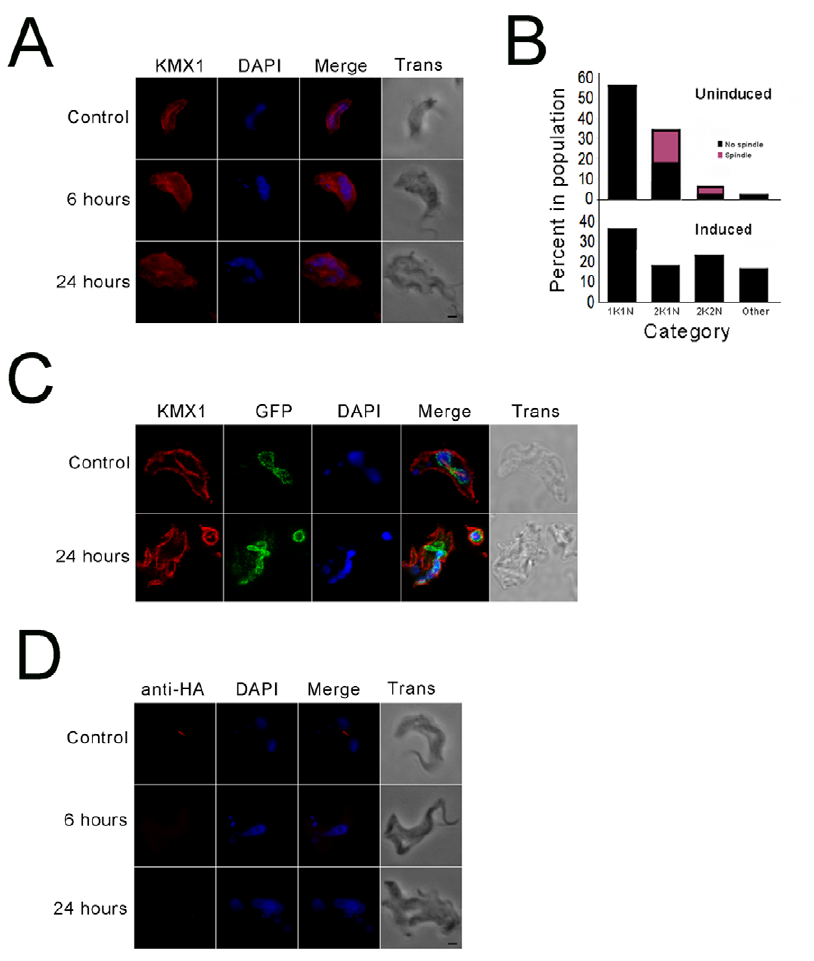
Figure 7. Suppression of TbRHP leads to spindle abnormalities. (A) BSF trypanosomes after 0 (control), 6, or 24 hours TbRHP RNAi induction were probed with anti- b -tubulin antibody (KMX1, red). DAPI was used to visualize DNA (blue). Note the presence of a clear spindle in the control cells and the complete absence of any large tubulin structure associated with the nucleus in the induced cells. Bar, 2 m m. (B) Quantitation of proportion of BSF cells with detectable spindles. Top panel shows uninduced cells, where the population is segregated by position in the cell cycle. Lower panel following 24 hours induction for TbRHP RNAi. K; kinetoplast, N; nucleus. n . 200 for each analysis. (C) TbRHP RNAi was induced for 0 (control) or 24 hours in cells expressing TbNUP98-GFP (green) and cells were probed with anti- b -tubulin antibody (KMX1, red). DAPI was used to visualize DNA (blue). Spindles and segregated nuclei were observed in control cells, while in RNAi induced cells no spindles were observed and nuclei remained juxtaposed, but they did form individual nuclear envelopes as evidenced by TbNUP98-GFP fluorescence. (D) TbRHP RNAi was induced for 0 (control), 6, or 24 hours in cells expressing TbAUK1-HA. Cells were probed with an anti-HA antibody. TbAUK1-positive spindles were clearly observed in control cells but were completely absent in TbRHP depleted cells at 6 and 24 hours after induction. Bar, 2 m